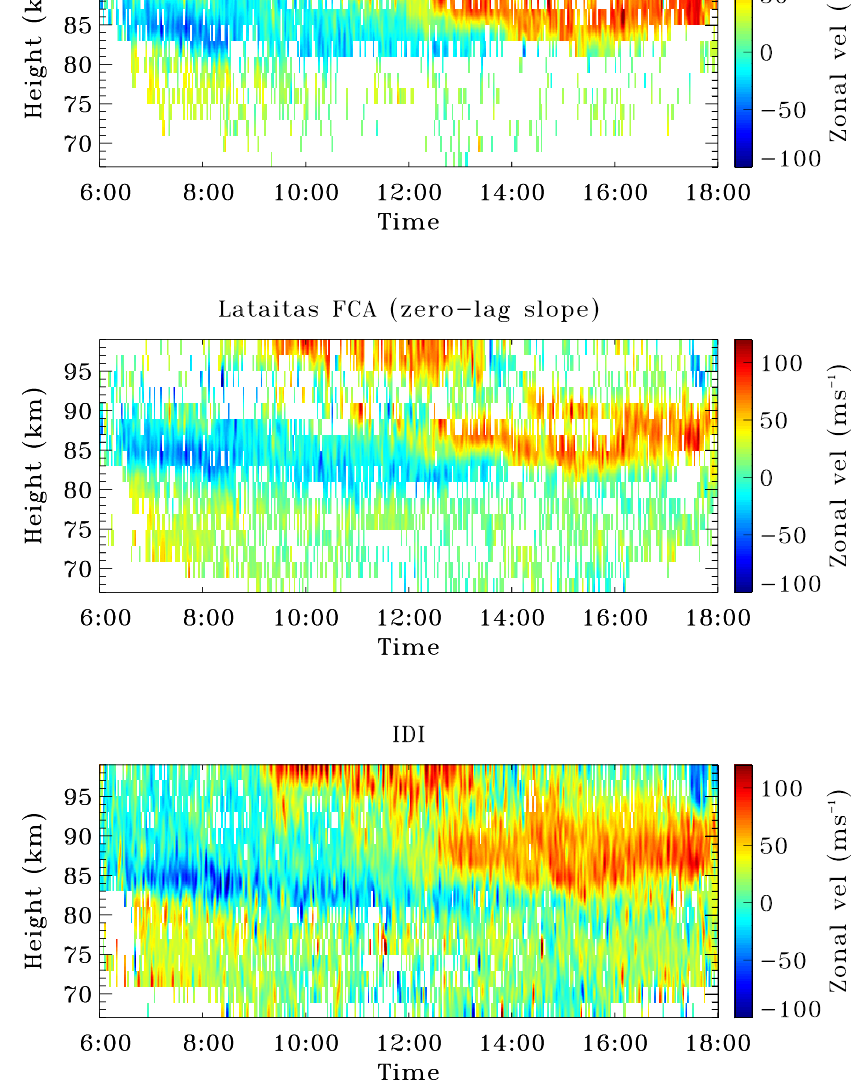
Fig. 6. Zonal wind velocities estimated during daytime 4 March 2002 by FCA (top), Lataitas zero-lag CCF slope fitting correlation analysis (middle), and IDI